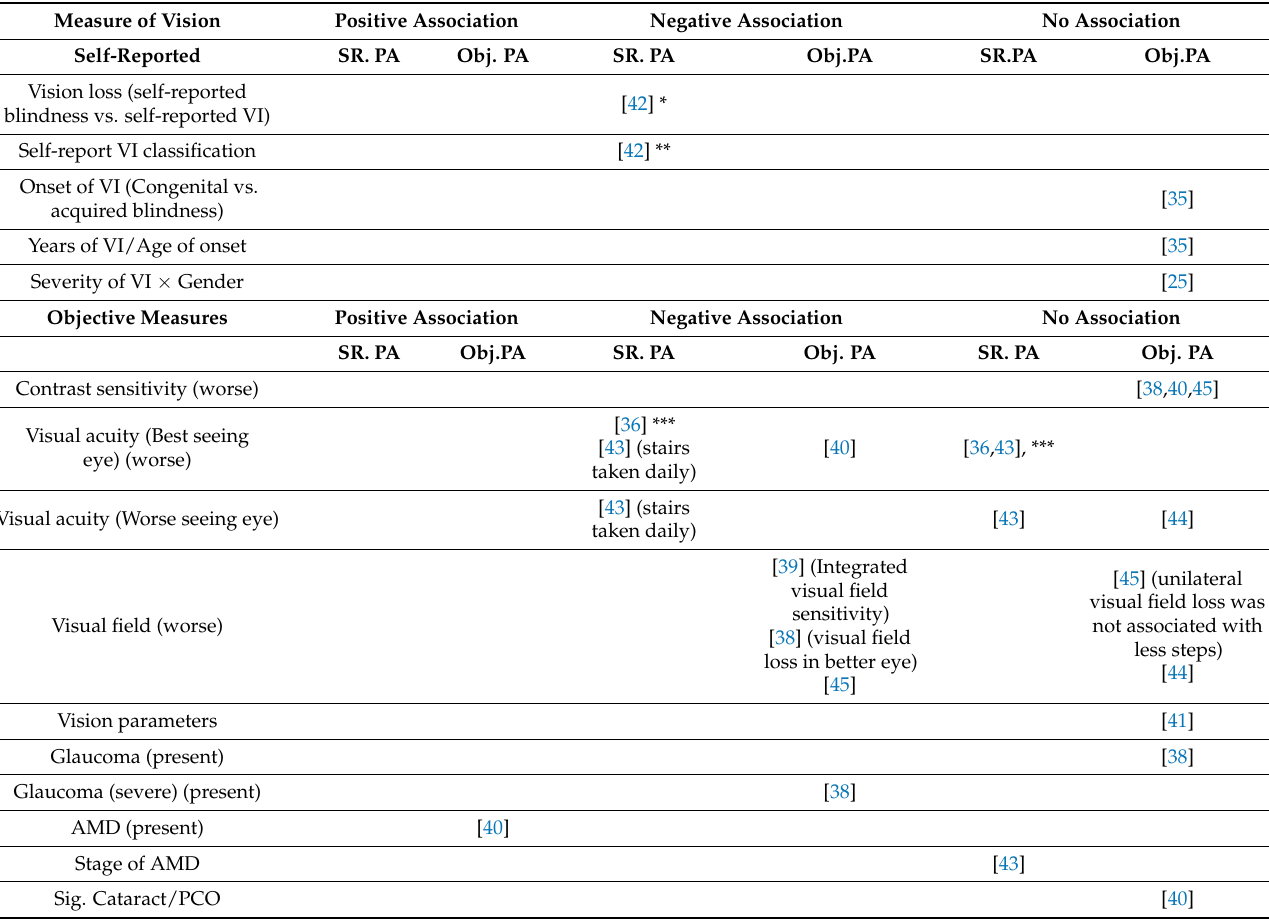
Table 4. Measures of vision and association with